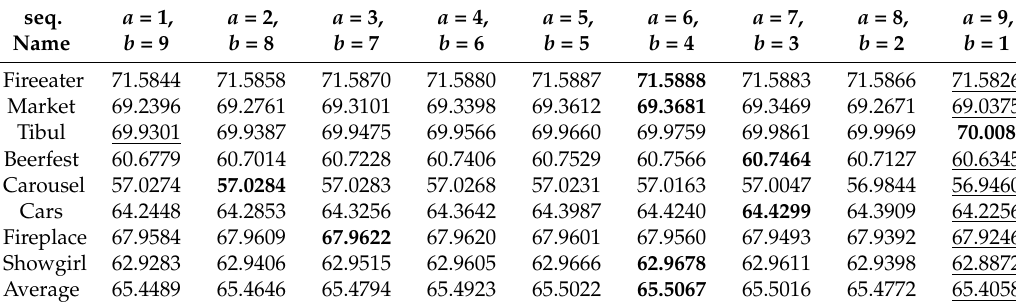
Table 2. Changes of the performance (tPSNR-Y) according to the parameters a and b of (22). The figures in boldface and with underline in each row represent the best and the worst performance for each test